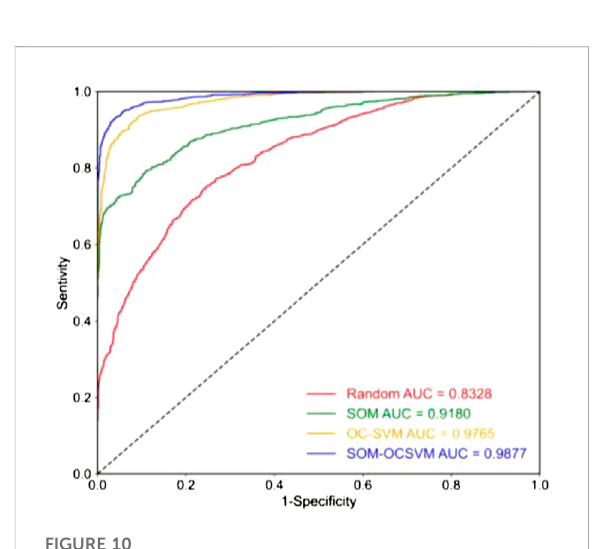
FIGURE 10 ROC curves of four non-landslide data generation strategies.